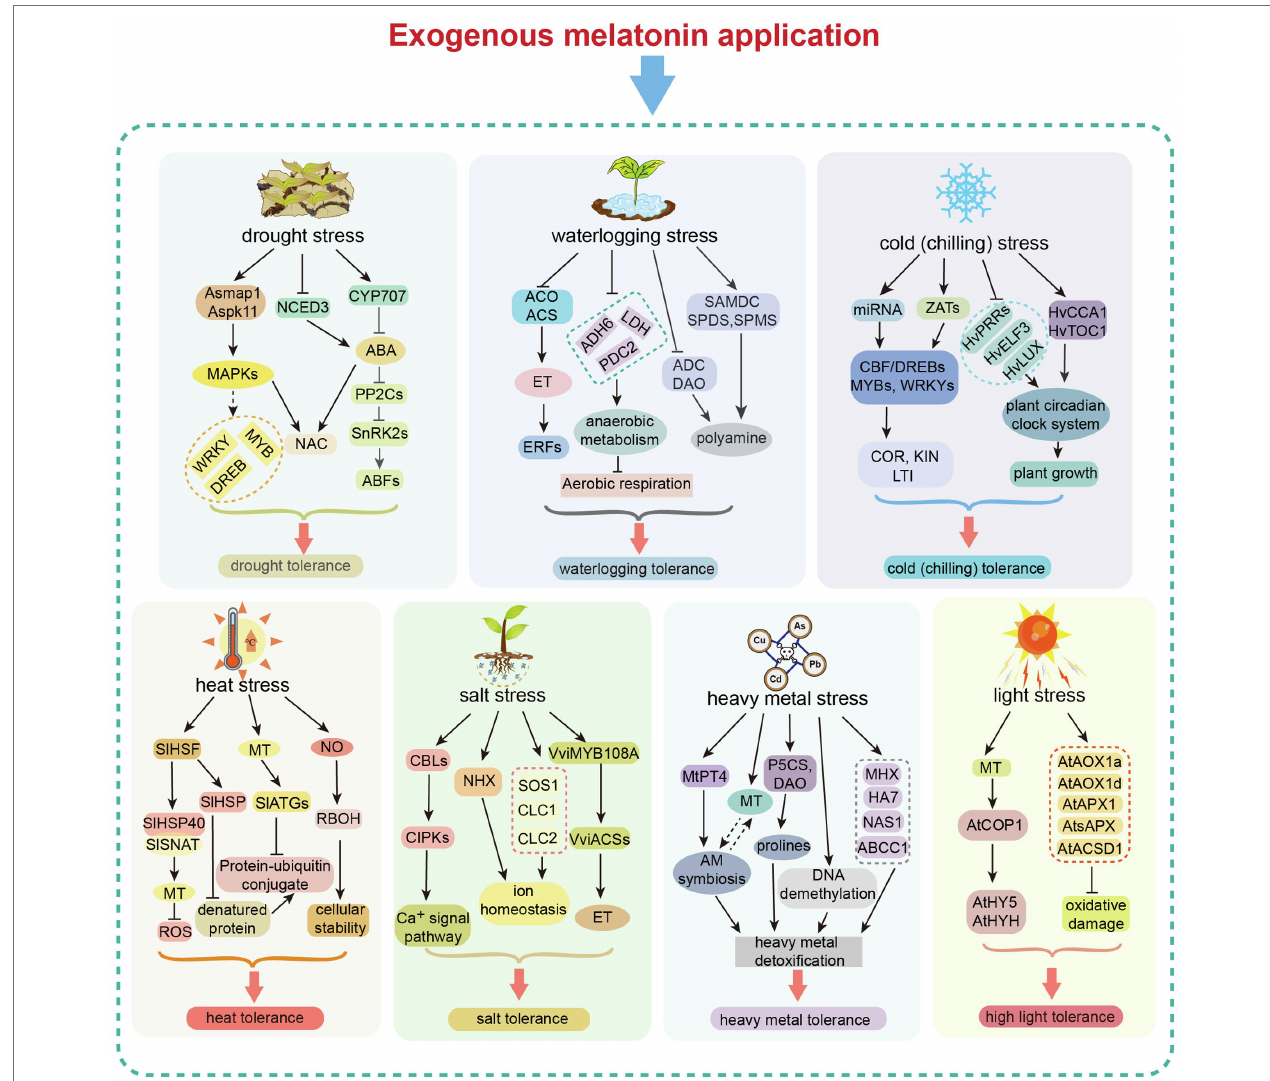
FIGURE 4 | Exogenous melatonin-mediated regulation in response to different abiotic stresses. Exogenous melatonin application induces changes in gene expression in different abiotic stress response pathways, resulting in enhanced tolerance to major abiotic stresses (drought, waterlogging, heat, cold, salt, heavy metal toxicity and light). MAPK, mitogen-activated protein kinase; NCED3, nine-cis-epoxycarotenoid dioxygenase 3; NAC, N-acetylcysteine; DREB, dehydration responsive element binding; CYP, cytochrome P450; PP2C, protein phosphatase 2C; SnRK, sucrose non-fermenting–related related kinase; ABF, abscisic acid responsive element-binding factor; ABA, abscisic acid; ACO, acyl-CoA oxidase; ACS, acetyl-CoA synthetase; ET, ethylene; ERF, ETS2 repressor factor; ADH, alcohol dehydrogenase; LDH, lactate dehydrogenase; PDC2, pyruvate decarboxylase-2; SAMDC, S-adenosylmethionine decarboxylase; SPDS, spermidine synthase; SPMS, spermine synthase; ADC, arginine decarboxylase; DAO, di-amine acid oxidase; CBF/DREB, dehydration responsive element binding/C-repeat binding factor; ZAT, zinc transporter; COR, cold-regulated gene; KIN, Kin17 DNA and RNA binding protein; LTI, low-temperature-induced genes; PRRs, pseudo- response regulators; ELF3, E74 like ETS transcription factor 3; CCA1, circadian colck associated 1; TOC1, timing of CAB expression 1; HSF, heat shock facter; HSP, heat shock protein; SNAT, serotonin N-acetyltransferase; MT, melatonin; RBOH, respiratory burst oxidase homolog; ATG, autophagy-related; CBL, calcineurin B-like proteins; CIPK, CBL-interacting protein kinases; NHX, Na + /H + exchanger protein; SOS1, SOS Ras/Rac guanine nucleotide exchange factor 1; CLC, chloride channel; PT4, phosphate transporter 4; AM, arbuscular mycorrhizal; P5CS, delta 1-pyrroline-5-carboxylate synthase; DAO, D-amino acid oxidase; MHX, magnesium/proton exchanger; NAS1, nicotianamine synthase 1; nicotianamine synthase 1; COP1, constitutive photomorphogenic 1; HY5, elongated hypocotyl 5; HYHAPX, hy5 homolog; APX, ascorbate peroxidase; AOX, aldehyde oxidase; and ACSD, 2-amino-3-carboxymuconate-6-semialdehyde